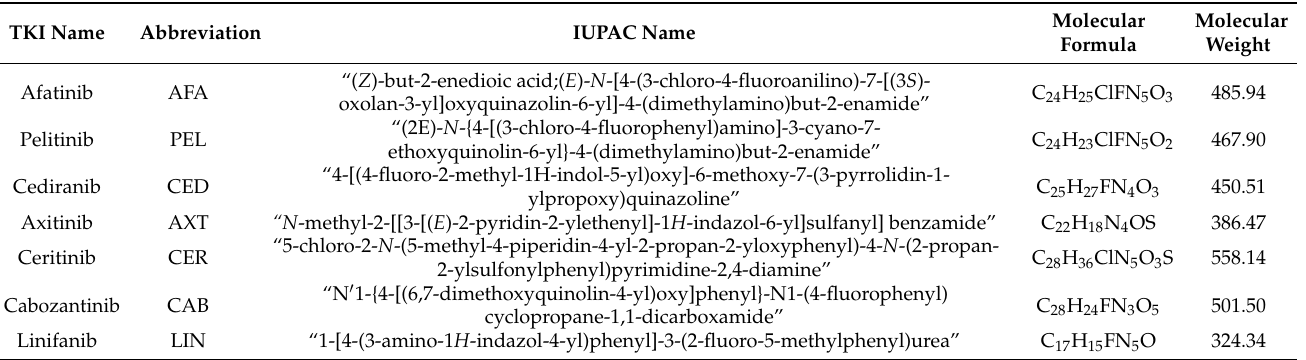
Figure 1. The chemical structures of the investigated tyrosine kinase inhibitors (TKIs) with their abbreviations. Asterisk symbols (*) denote the electron-donating sites of interactions of TKIs with iodine and form CTC. Table 1. The investigated TKIs with their abbreviations, (International Union of Pure & Applied Chemistry (IUPAC) names, molecular formulae and molecular weights.